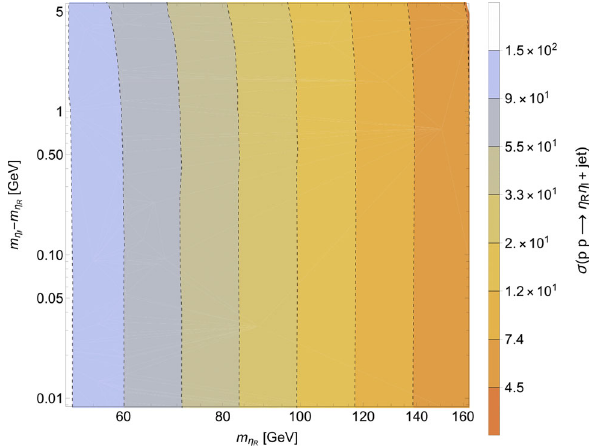
− m η as a function of m η in mono-jet I R R